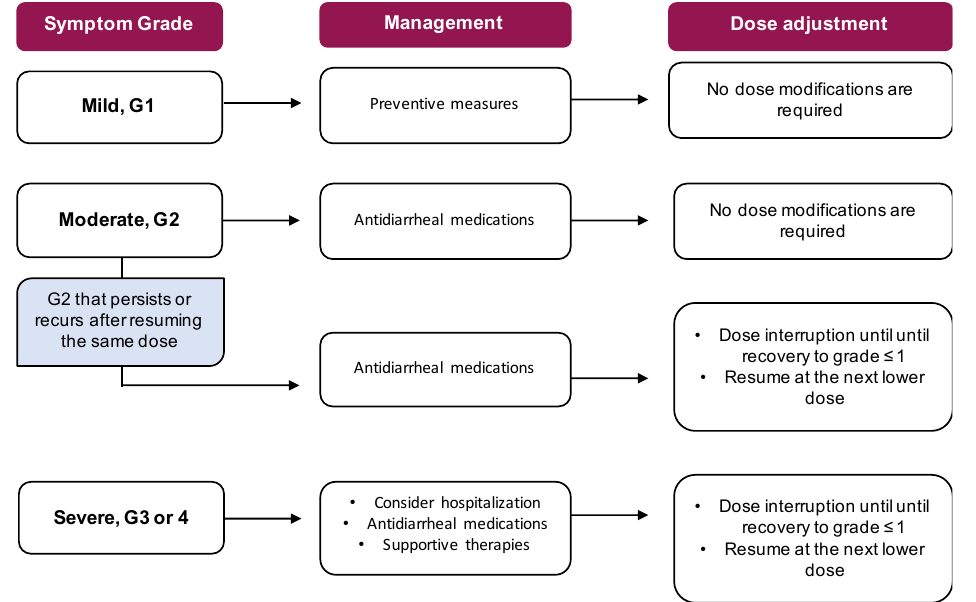
Figure 3. Dose modifications and management of CDK4/6 inhibitors.